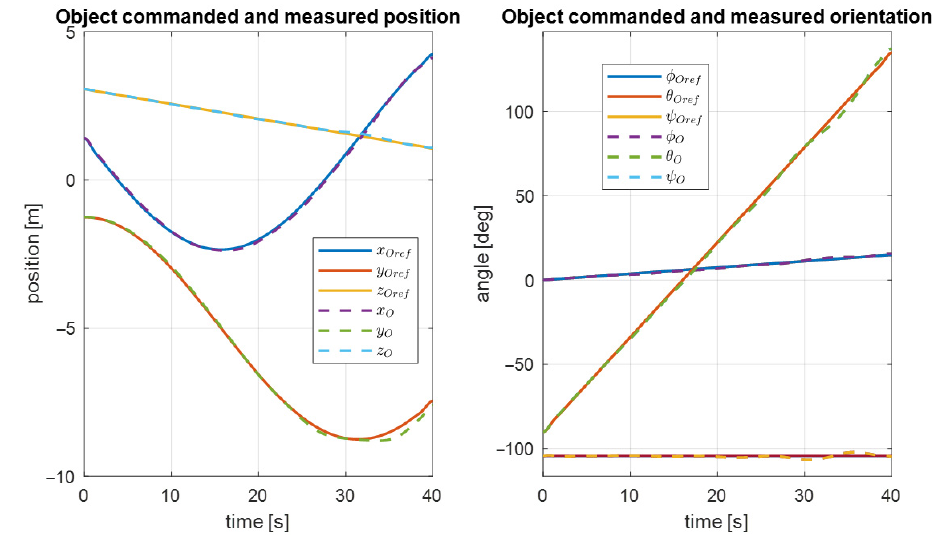
Figure 13. Measured and commanded positions of the object.